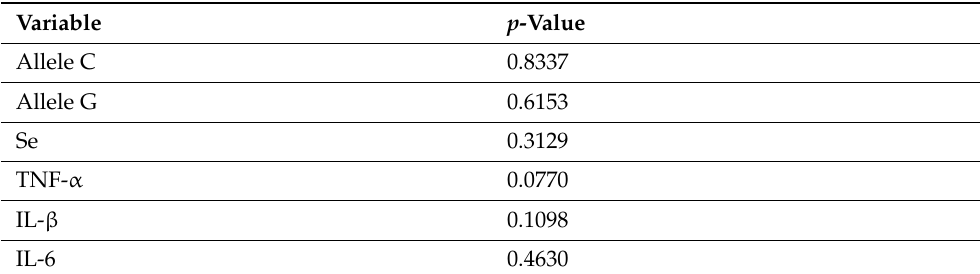
Table 13. Influence of the proinflammatory cytokines (IL-1 β , IL-6, TNF- α ) on depressive symptoms with regard to the effect of selenium.